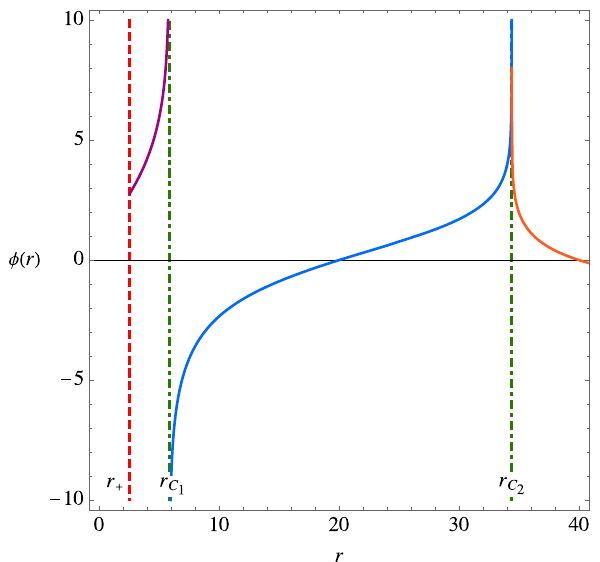
Fig. 15 The change in the φ -coordinate during the time-like critical orbits, classified by colours, in accordance with different ranges of the initial radial distance r j